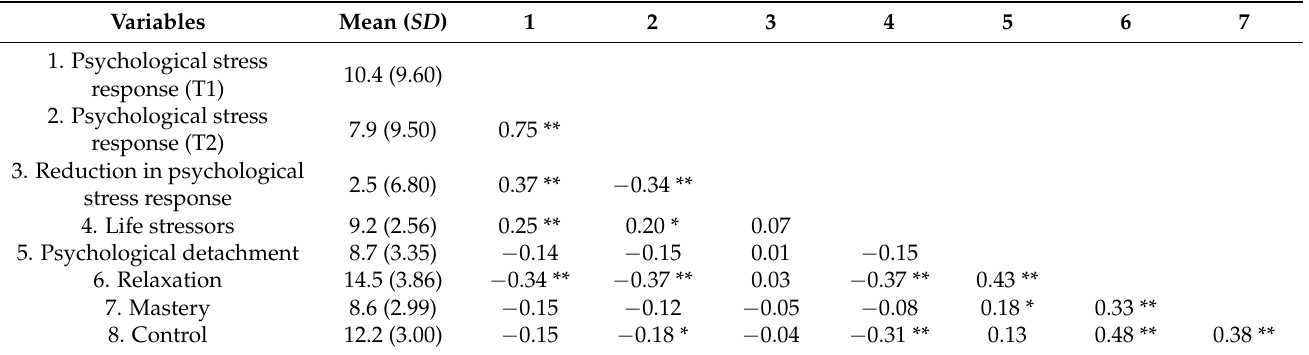
Table 2. Means, standard deviations, and correlations between variables ( n =